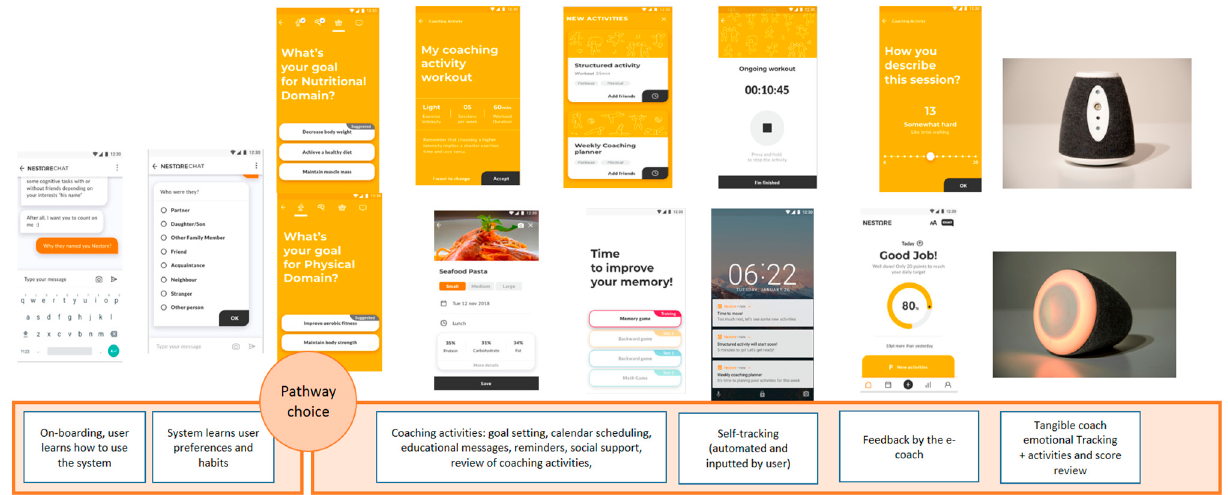
Figure 9. Intervention delivery trough the main coaching interfaces.